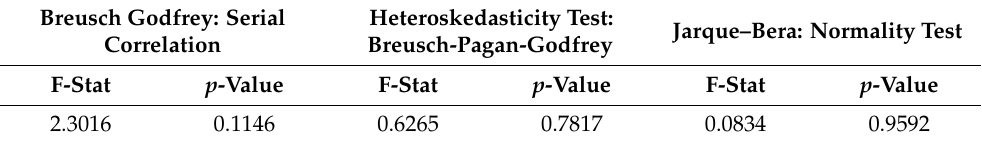
Table 7. Residual diagnostic tests.